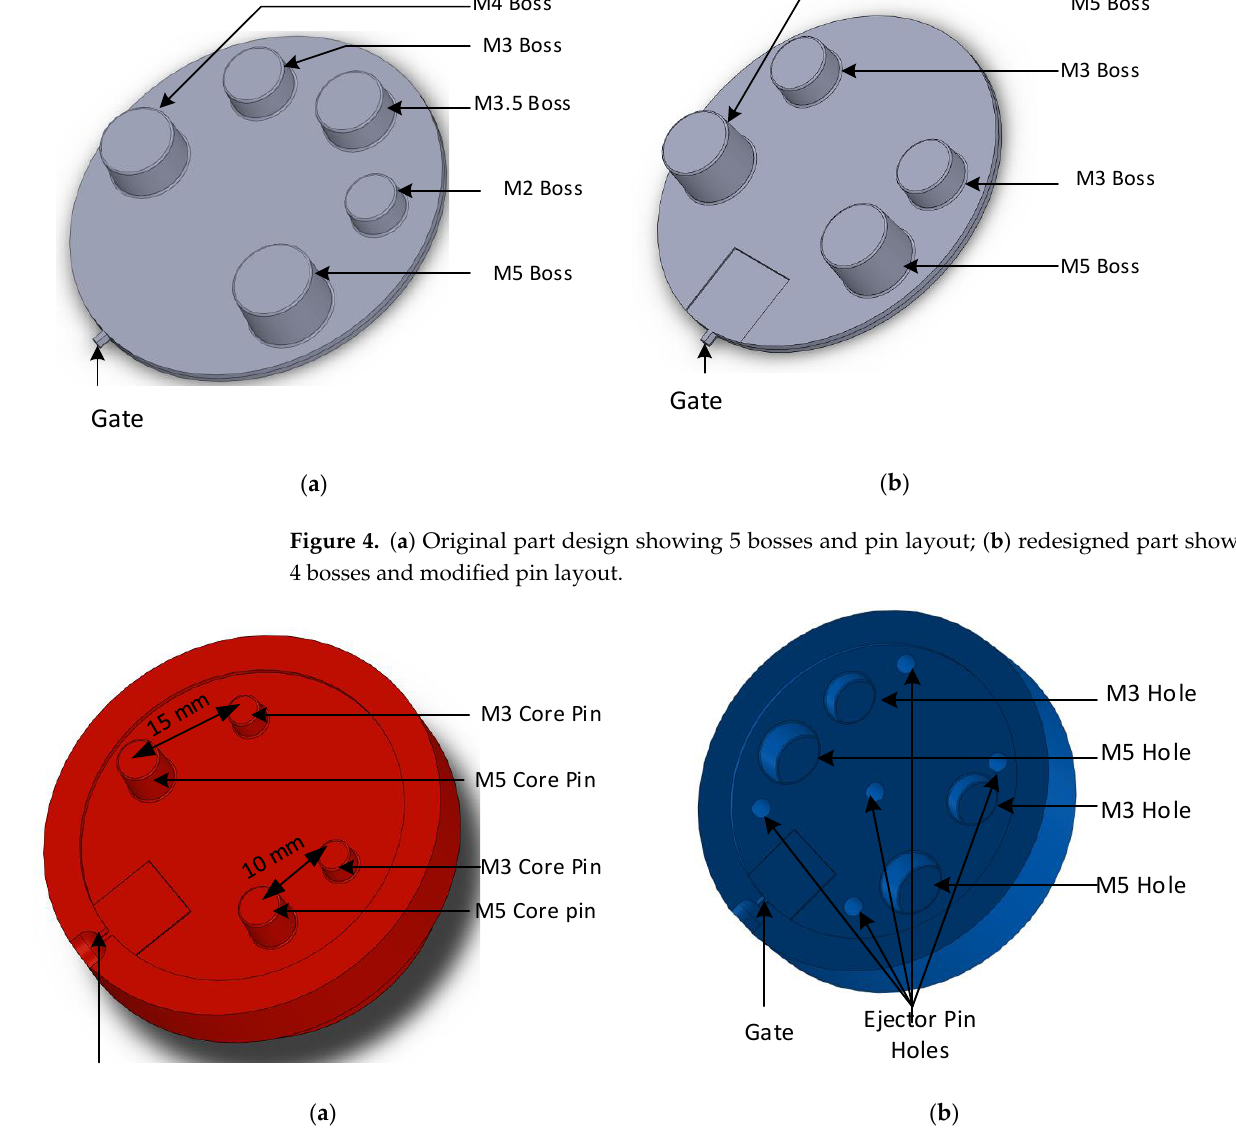
Figure 5. ( a ) Core side of 3DIM showing the raised features (core pins) and the distance between core pins; ( b ) Cavity side of 3DIM showing the core holes and ejector pin hole placement.